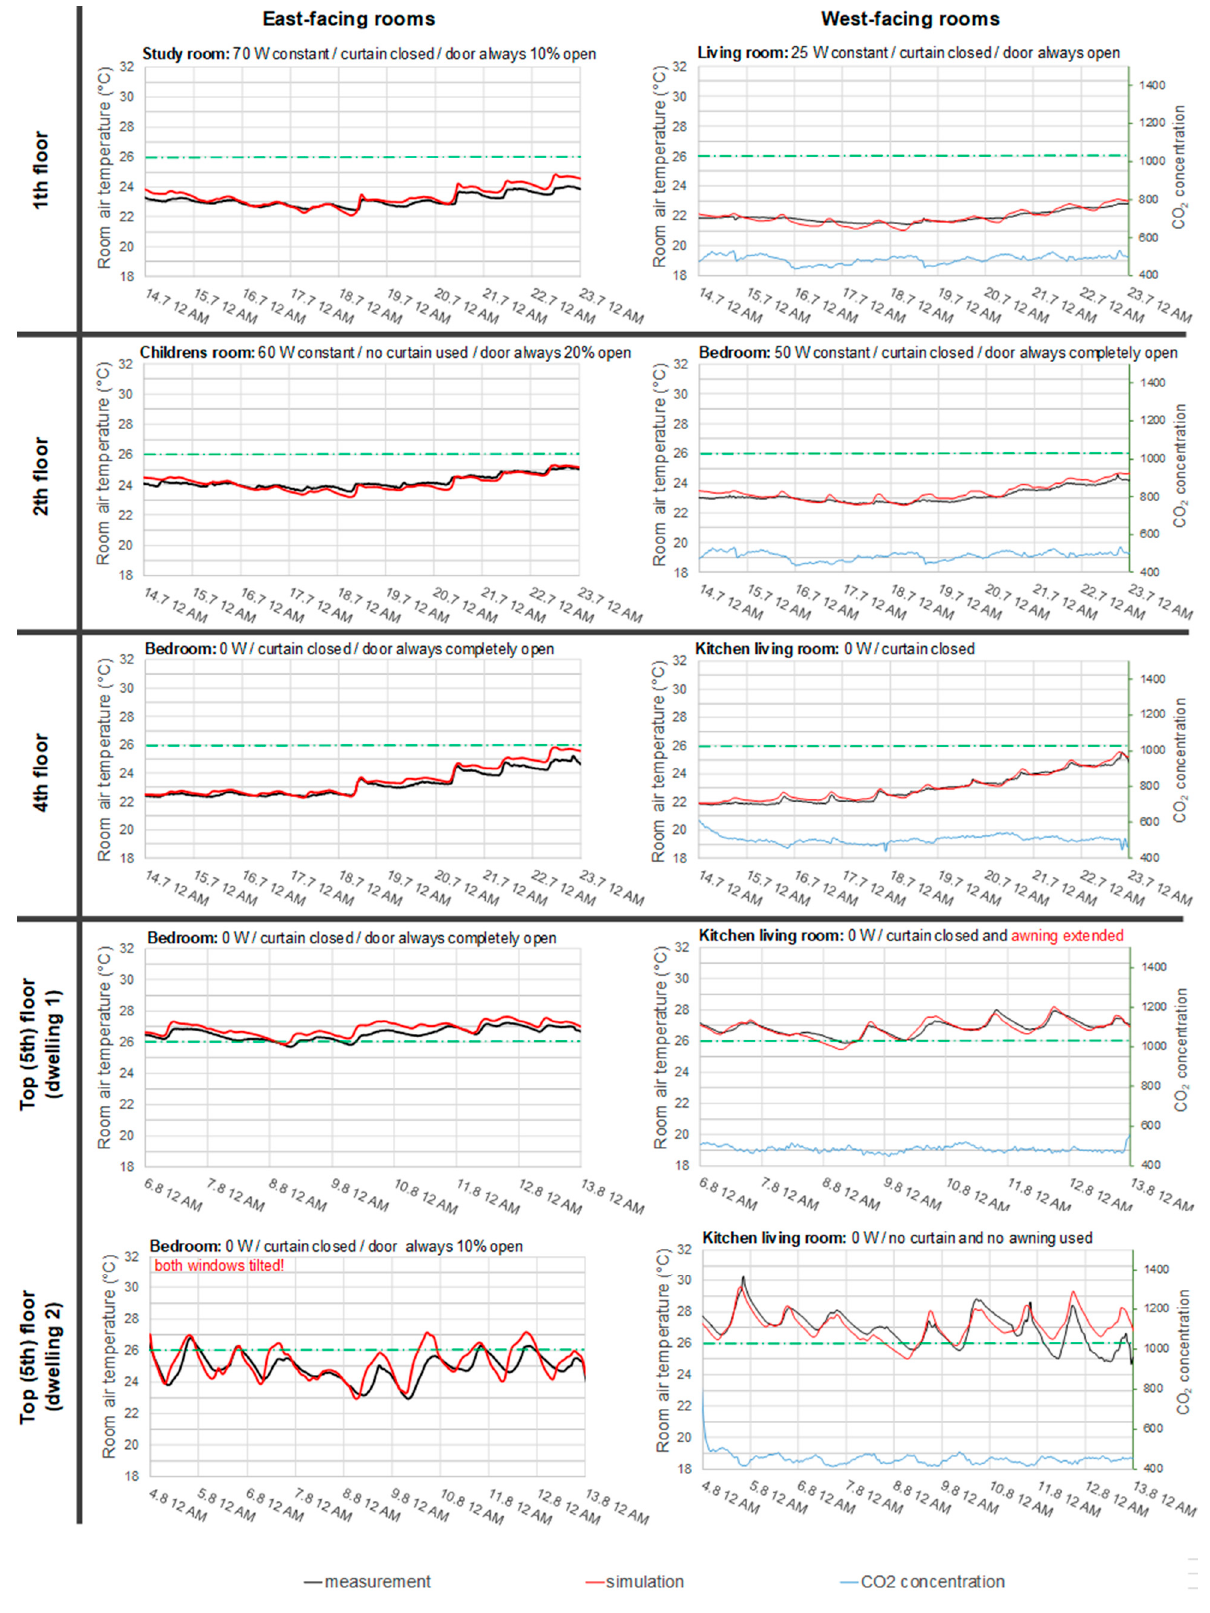
Figure A3. Measured (black line) and simulated (red line) room temperature profiles for all rooms monitored in the GZH dwellings during the period of absence of the residents (see relatively constant CO 2 concentration at typical outdoor level of 400 ppm). The simulation parameters for the individual rooms of the final simulation variant are written above each diagram.